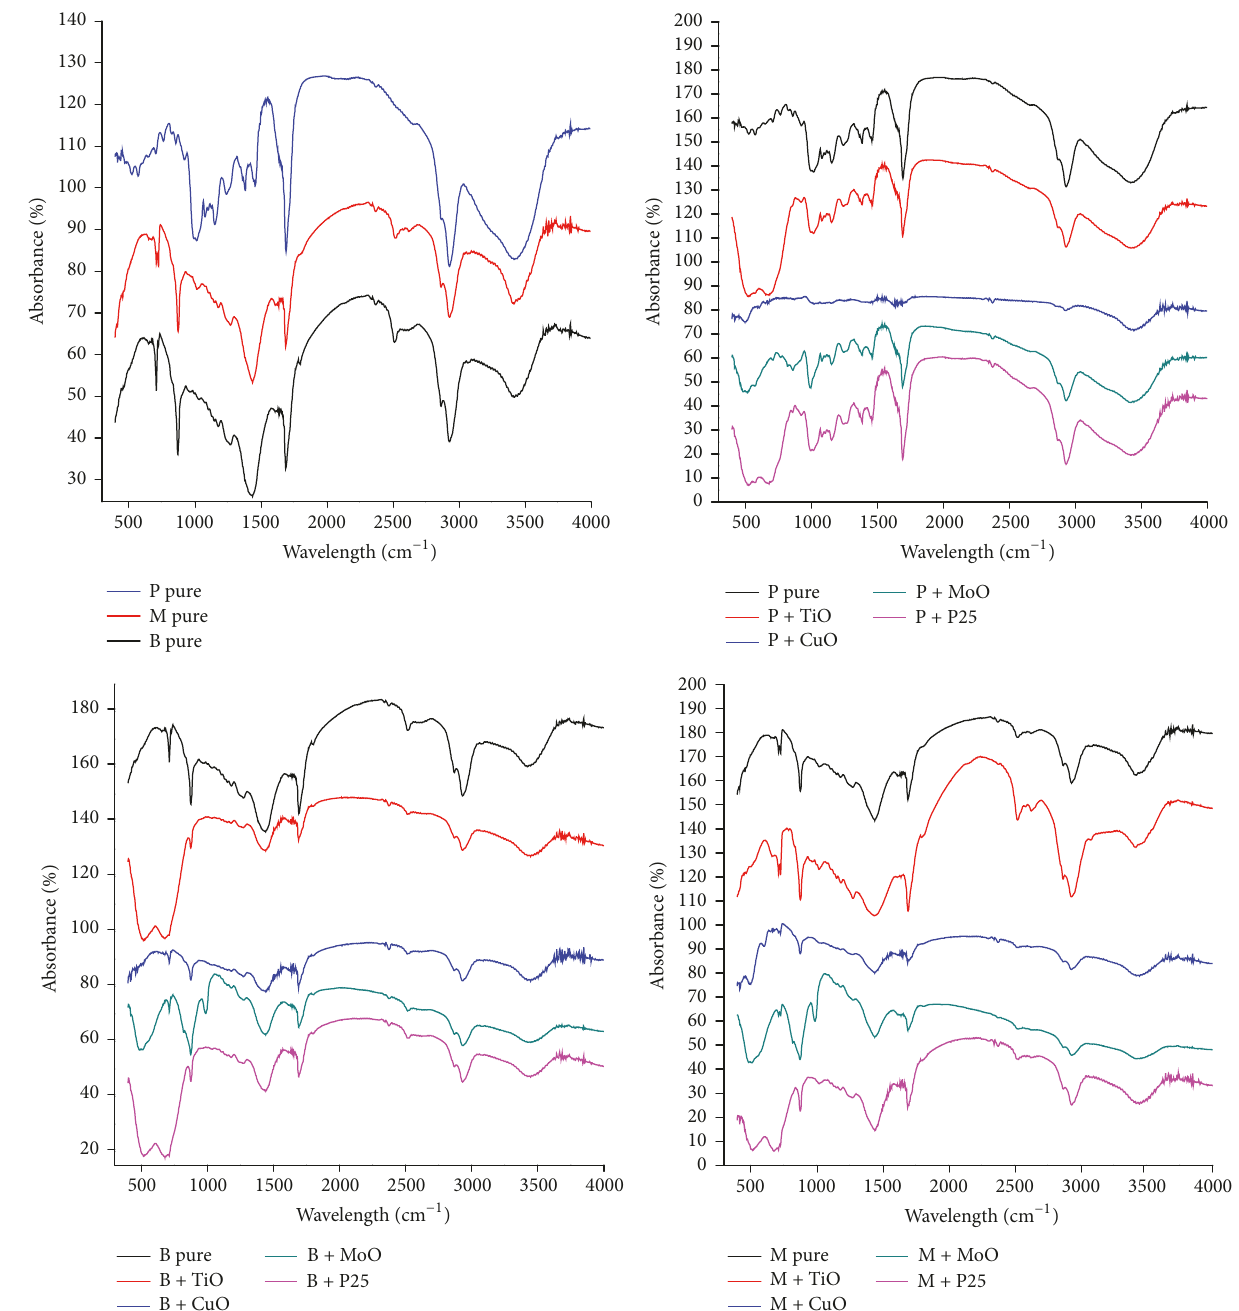
Figure 5: FTIR spectra of samples in pure state and also doped with metal oxides